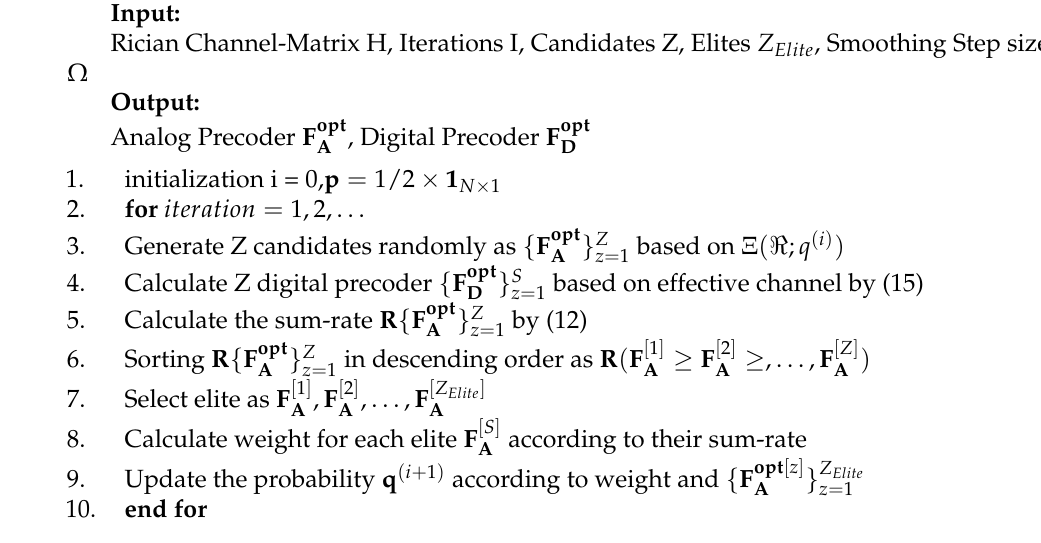
Algorithm 1 ACE-based hybrid precoding with sub-connected phase shifters